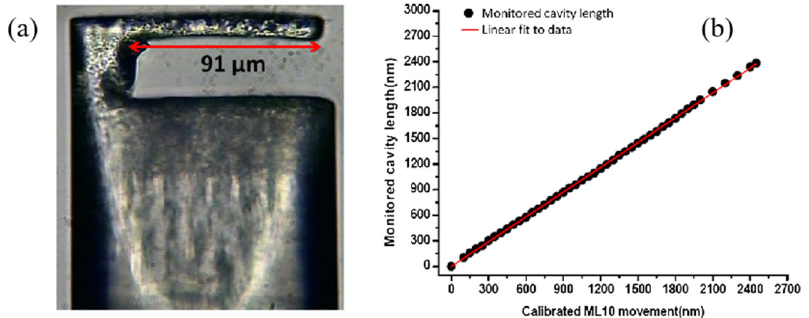
Figure 5. ( a ) Laser ‐ machined fiber microcantilever. ( b ) Displacement performance